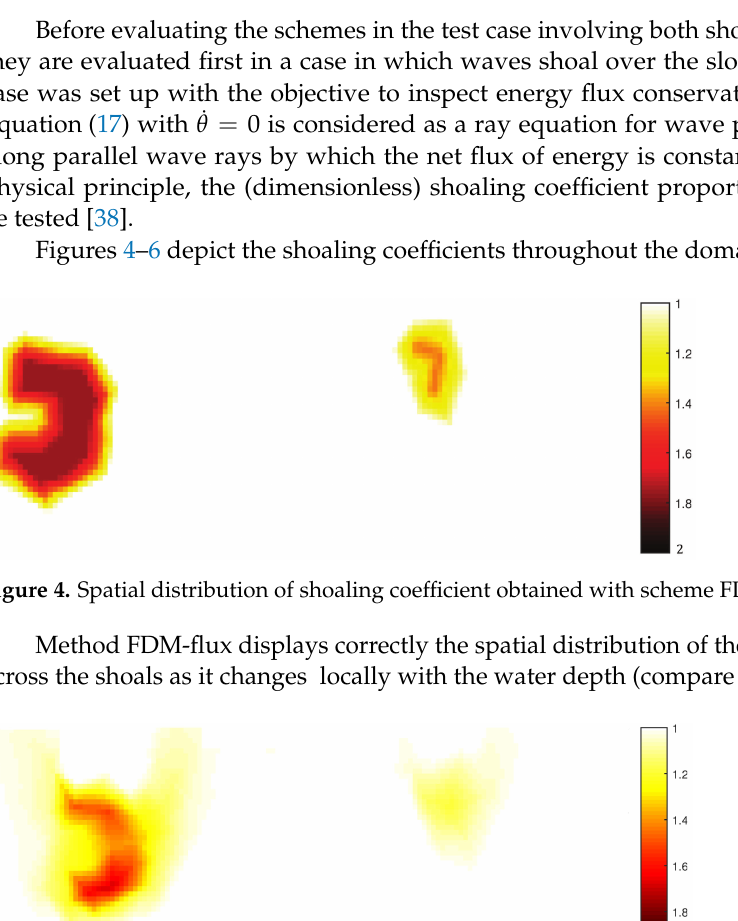
Figure 3. A part of the square domain with bathymetry (in m) of the submerged shoals case as interpolated to the unstructured triangular mesh.